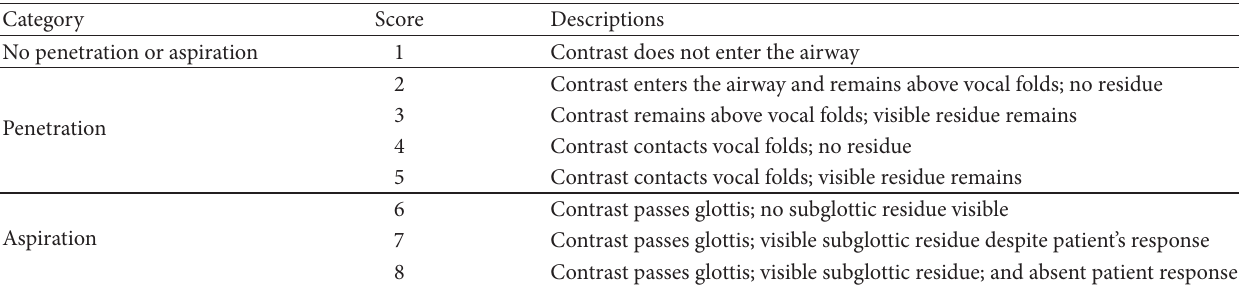
Table 1: Penetration-Aspiration Scale.